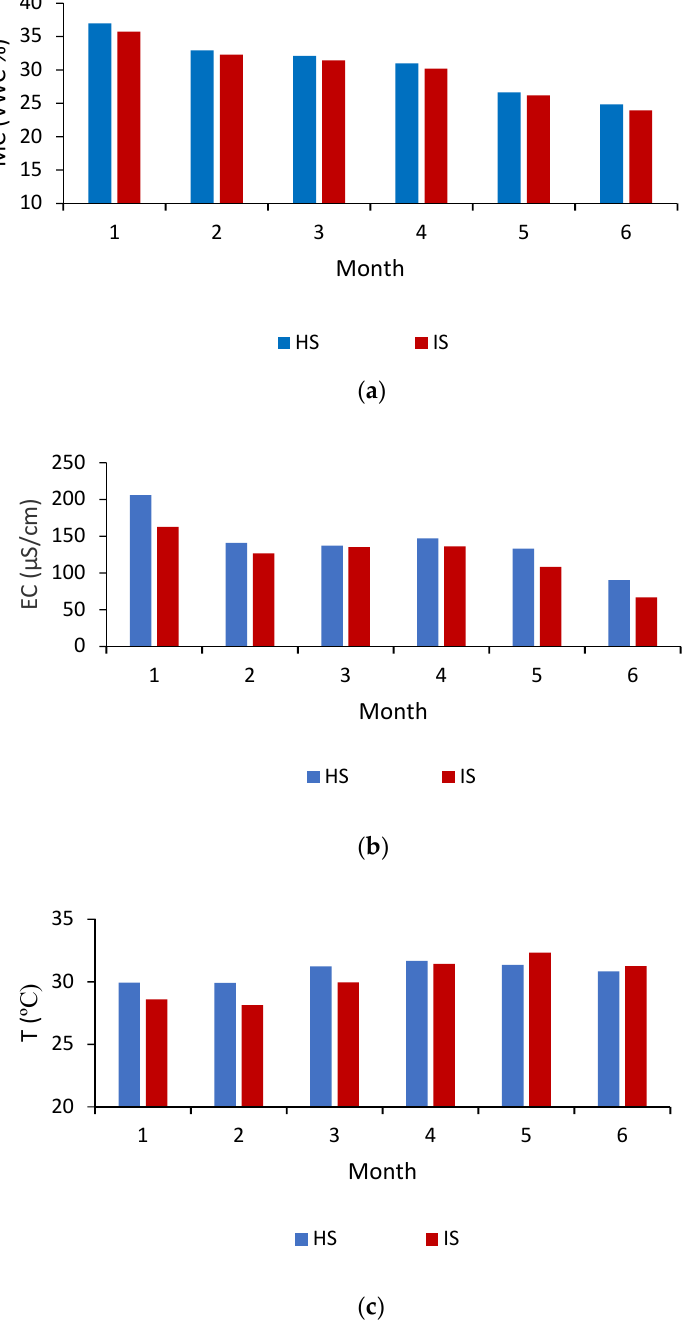
Figure 6. Mean of soil ( a ) moisture content (MC), ( b ) electrical conductivity (EC), and ( c ) tempera- ture (T) of healthy seedlings (HS) and infected seedlings (IS) over six months.